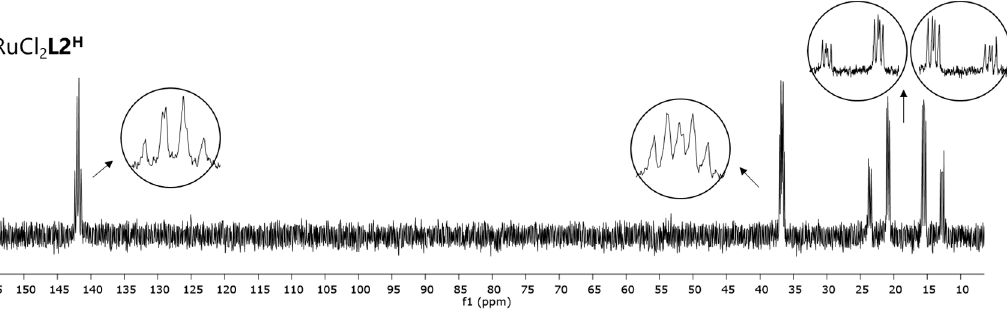
Figure 6. 31 P-NMR spectrum of RuCl 2 L2 H . Figure 6. 31 P NMR spectrum of RuCl 2 L2 H